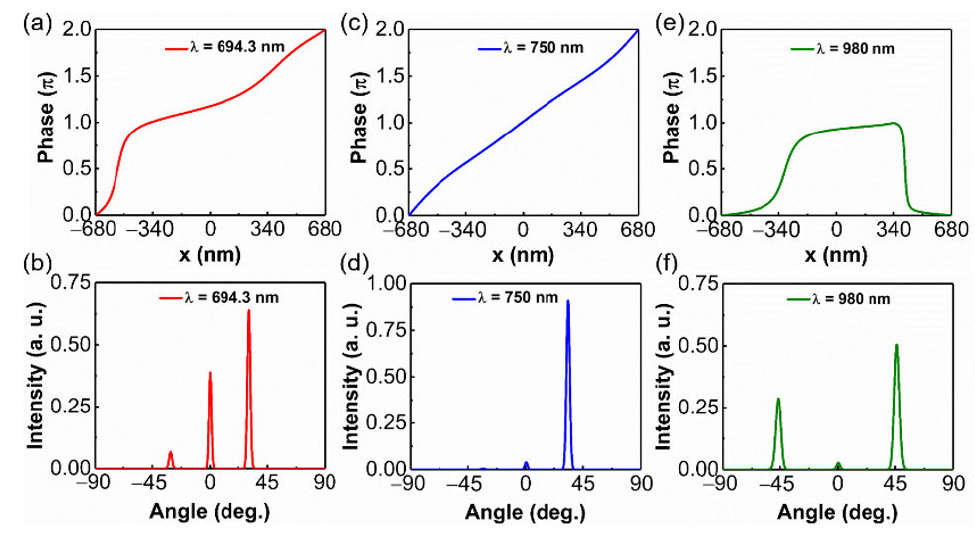
Figure 4. Phase response for x-polarized plane wave incidence at the wavelengths of ( a ) 694.3 nm, ( c ) 750 nm, ( e ) 980 nm. Far-field diffraction patterns for x-polarized plane wave incidence at the wavelengths of ( b ) 694.3 nm, ( d ) 750 nm, ( f ) 980